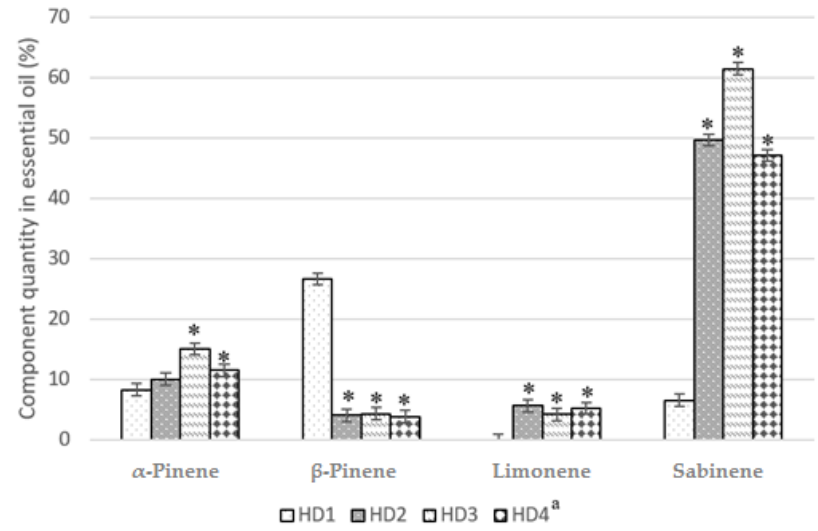
Figure 1. Magnesium aluminometasilicate’s influence on the amount of α and β -pinene, limonene, and sabinene in the essential oils of nutmeg. Component quantity in essential oils, * p < 0.05 versus